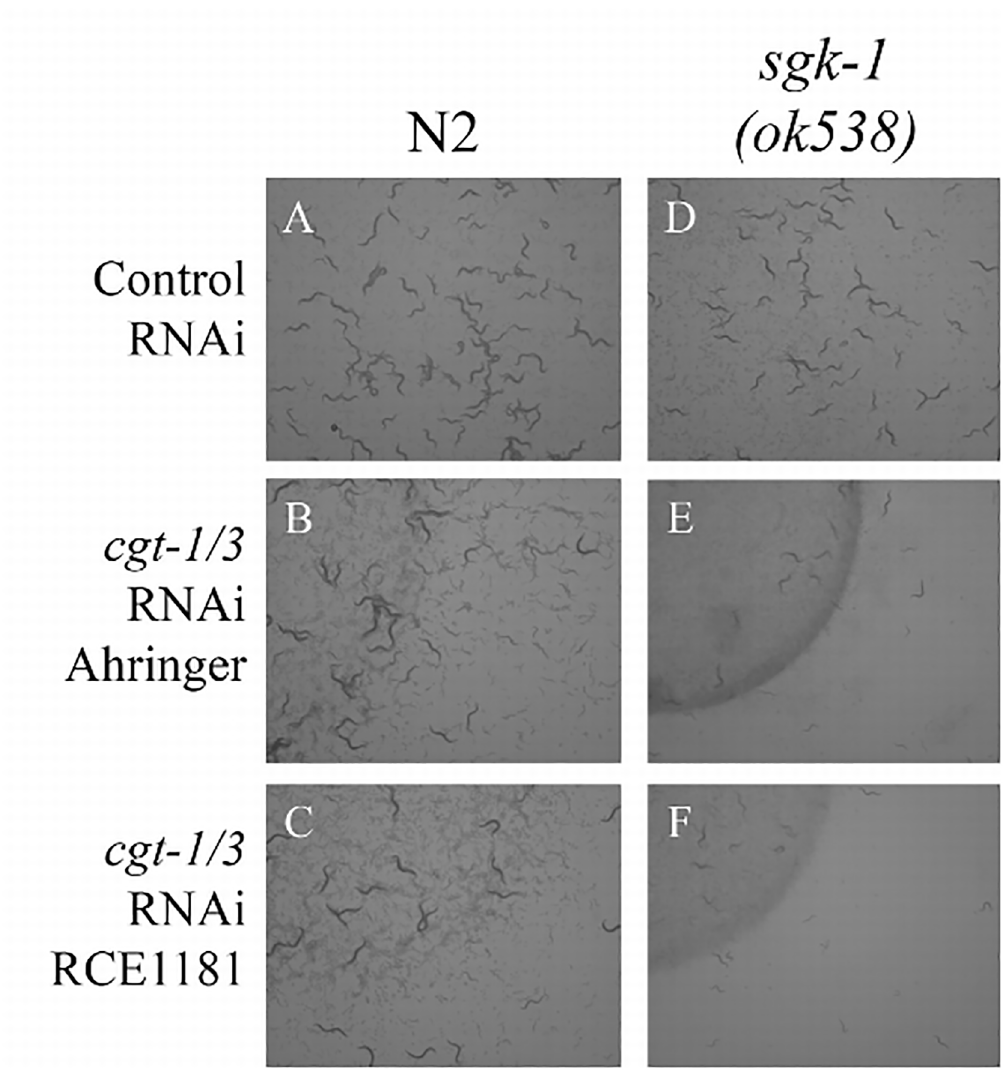
Fig 6. sgk-1 mutant worms treated with cgt-1/3 double RNAi developed very slowly. Images of wild type (A, B, C) and sgk-1(ok538) mutant animals (D, E, F) treated with control RNAi (A, D) and cgt-1/3 double RNAi from Ahringer library (B, E) and RCE1181 library (C, F). The experiments started with 5 gravid adult worms on each plate and the plates were imaged 5 days